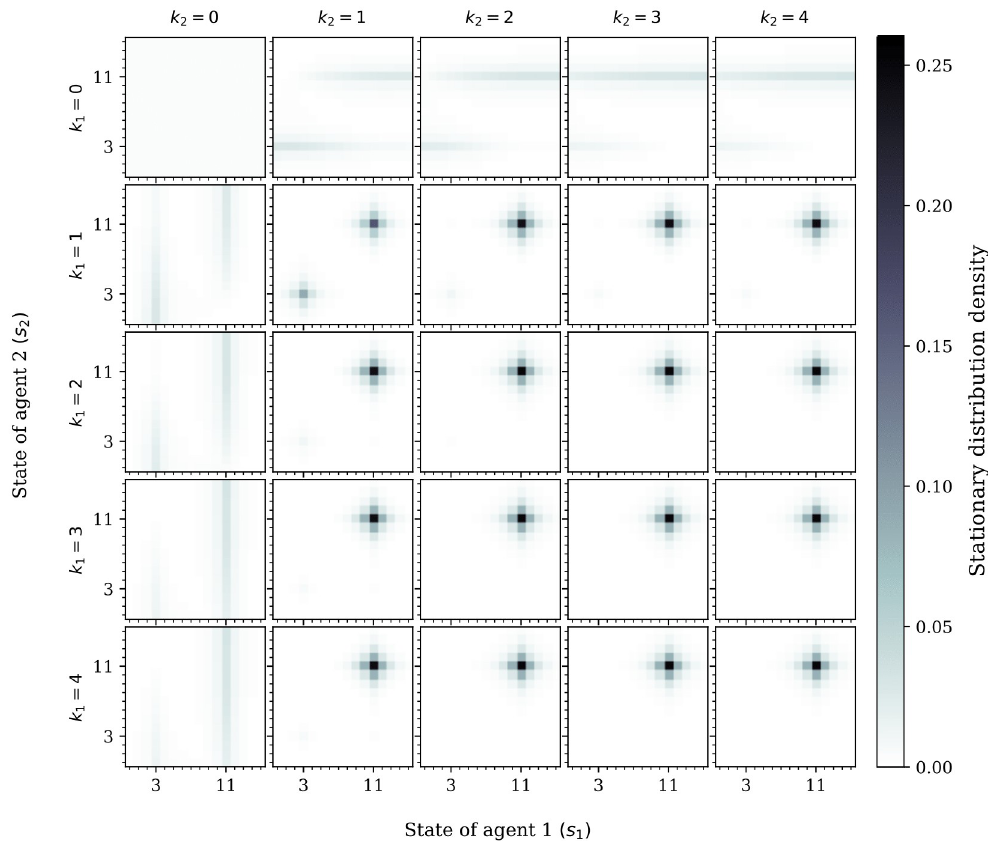
Fig 7. Role of sophistication level of CPT-agents in the stationary distributions of the Markov stag hunt game. Darker colors indicate higher probability. We assumed equal agent parameters (i.e., discount factors β 1 = β 2 = 0.9, reference point b 1 = b 2 = 0, utility functions u 1 ( x ) = u 2 ( x ) = x , and weighting function w